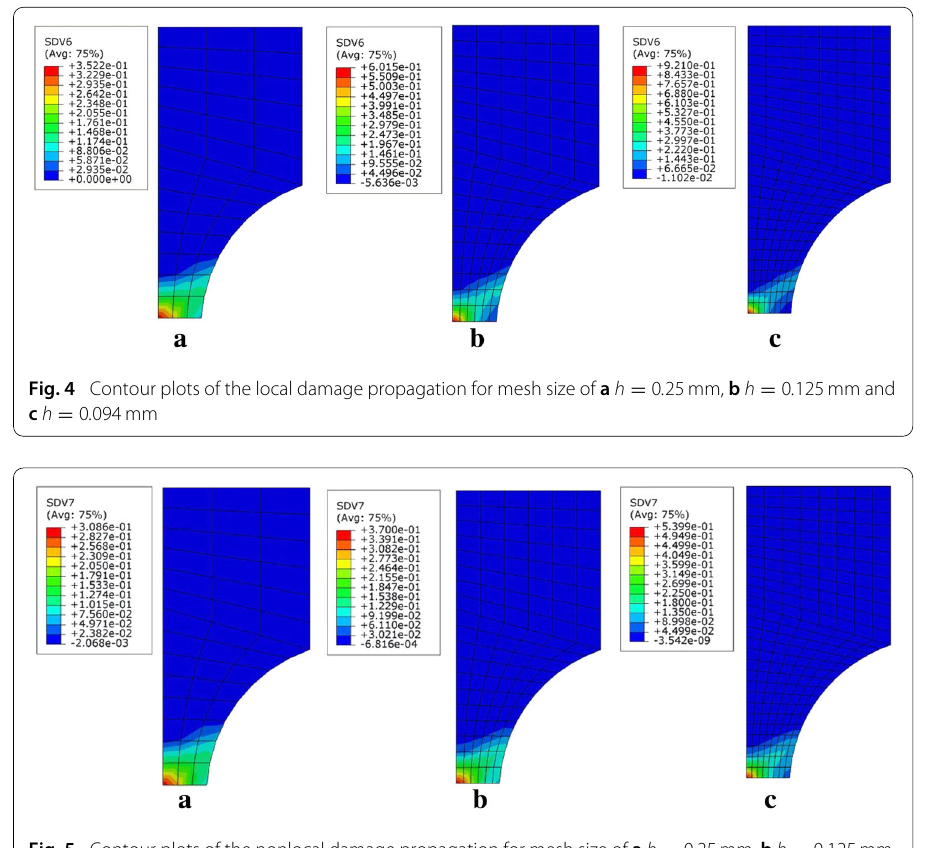
Fig. 5 Contour plots of the nonlocal damage propagation for mesh size of a h = 0 . 25mm, b h = 0 . 125mm and c h = 0 . 094mm